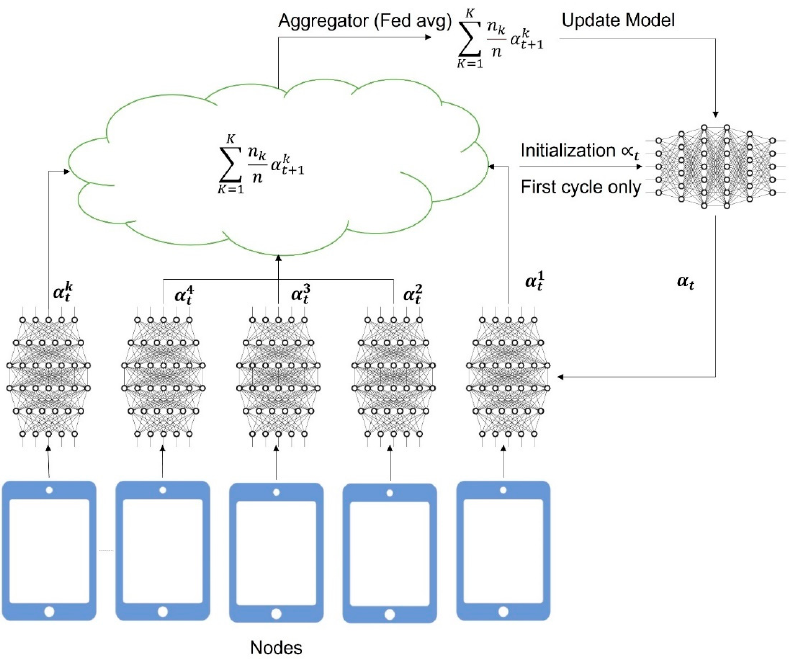
Figure 3. Diagrammatic representation of the FL architecture [35].